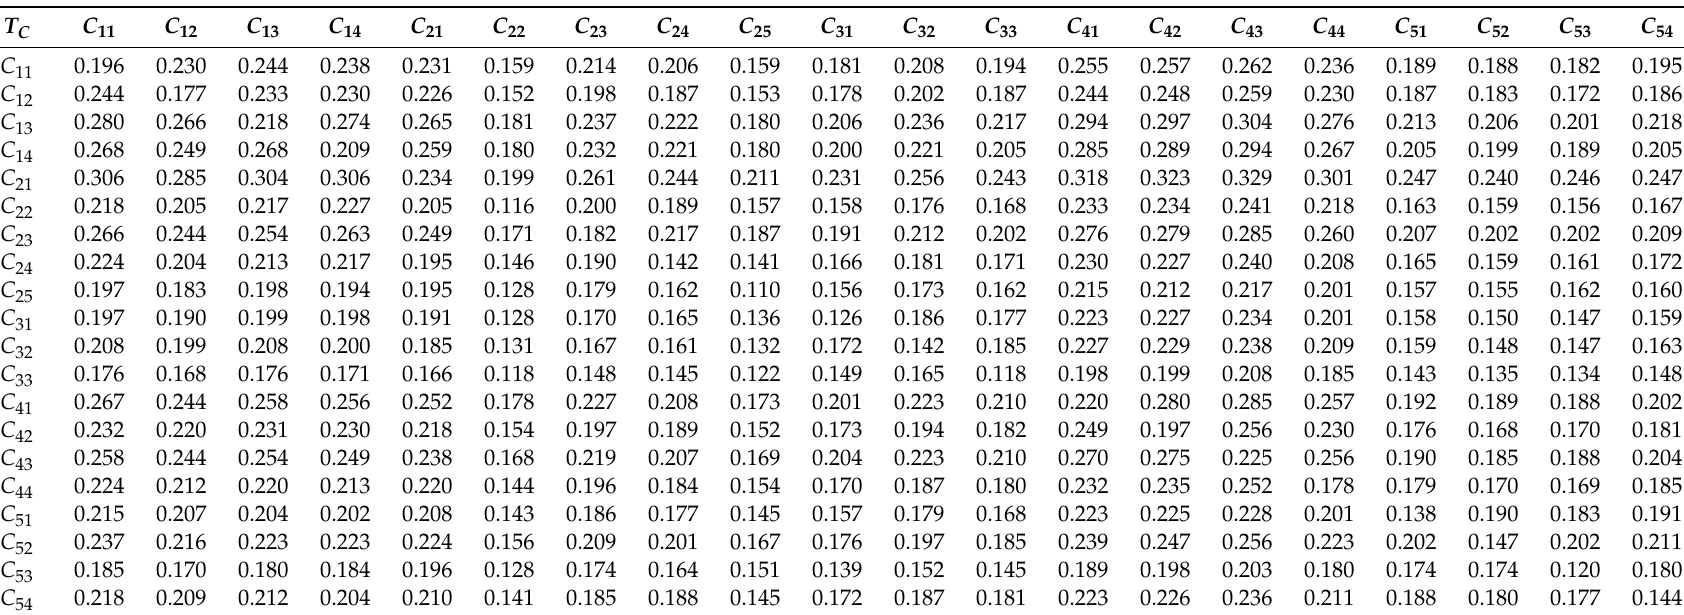
Table A3. The total influence matrix of criteria T